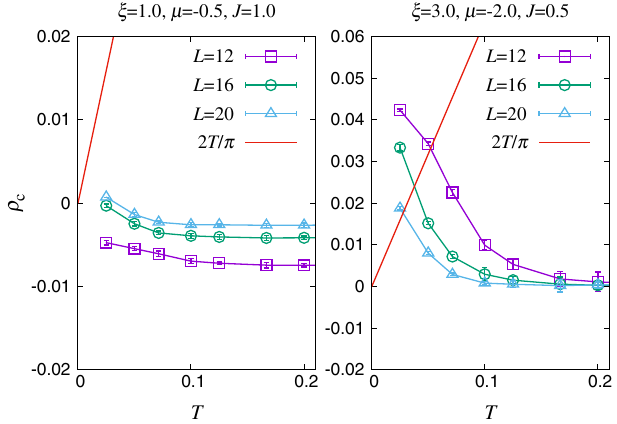
FIG. 12. Temperature dependence of ρ c at QCP for different system sizes and different couplings.